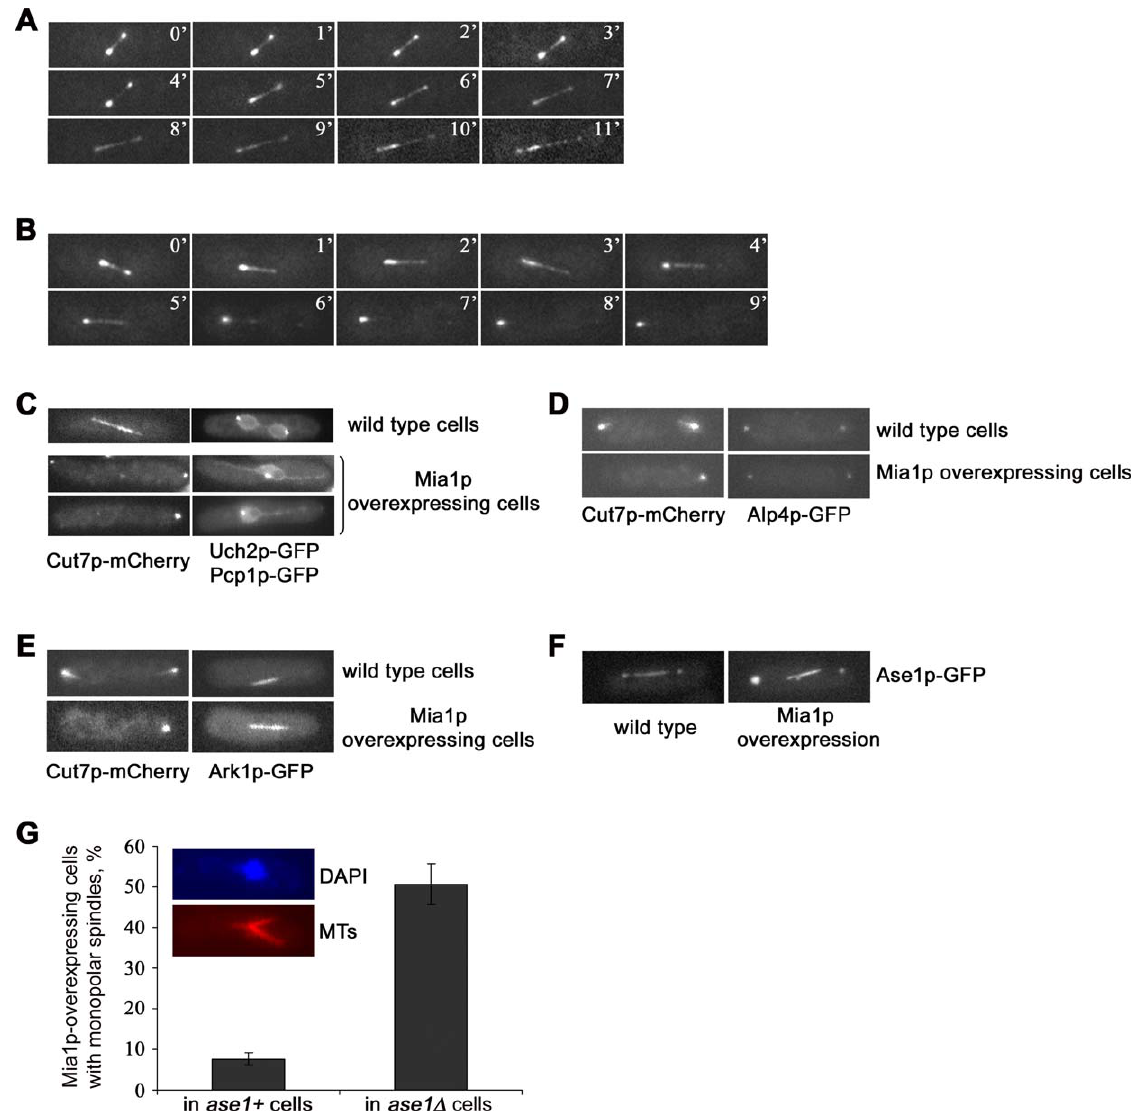
Figure 4. Spindle Structures in Mia1p-Overexpressing Cells Are Bipolar and Antiparallel (A) Time-lapse sequence of Cut7p-GFP–expressing wild-type cells undergoing spindle elongation. Numbers refer to the time, in minutes. (B) Time-lapse sequence of Mia1p-overexpressing Cut7p-GFP cells undergoing mitosis. Note that Cut7p-GFP clearly localizes to both poles early in anaphase and is progressively depleted from one of them as the cell progresses through mitosis. The midzone localization is similar to wild type. Shown are single maximum-intensity reconstructions of z -stacks. Numbers refer to the time, in minutes. (C) Cut7p-mCherry is enriched on acentrosomal spindle poles as judged by double fluorescence microscopy analysis with the SPB core marker, Pcp1p- GFP. Shown are single maximum-intensity reconstructions of z -stacks. (D) The c -TuRC marker, Alp4p-GFP, is present on acentrosomal poles in Mia1p-overexpressing cells, where it co-localizes with Cut7p-mCherry. Shown are single maximum-intensity reconstructions of z -stacks. (E) The chromosomal passenger complex protein, Ark1p-GFP, defines the spindle midzone in acentrosomal spindles. Shown are single maximum- intensity reconstructions of z -stacks. (F) Ase1p-GFP localizes to the spindle poles and spindle midzone in wild-type and Mia1p-overexpressing cells. Shown are single maximum-intensity reconstructions of z -stacks. (G) Graph quantifying the proportion of cells exhibiting monopolar spindles upon Mia1p overexpressing in wild-type and ase1 D genetic backgrounds ( n ¼ 300). Inset, immunofluorescence image of the monopolar spindle in a Mia1p-overexpressing ase1 D cell using anti– a -tubulin antibodies and the DNA dye, DAPI. MTs, microtubules.